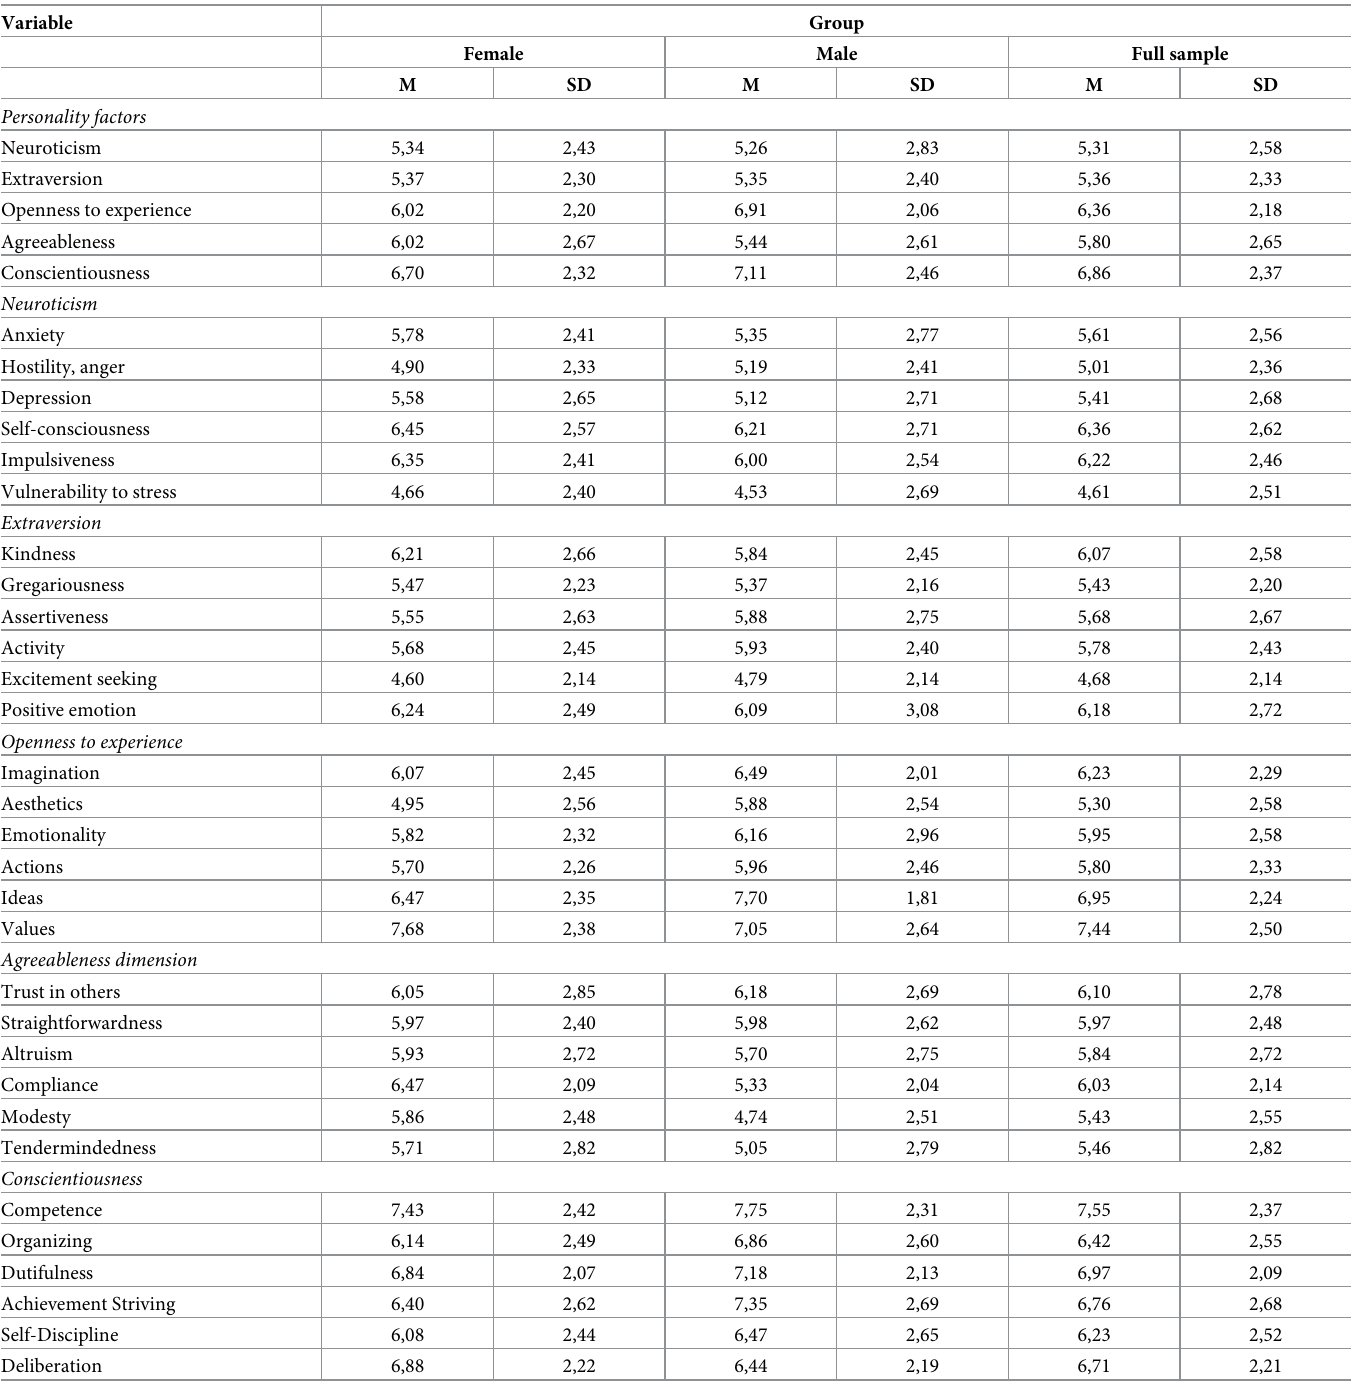
Table 1. Mean and SD for Big Five personality factors residualized